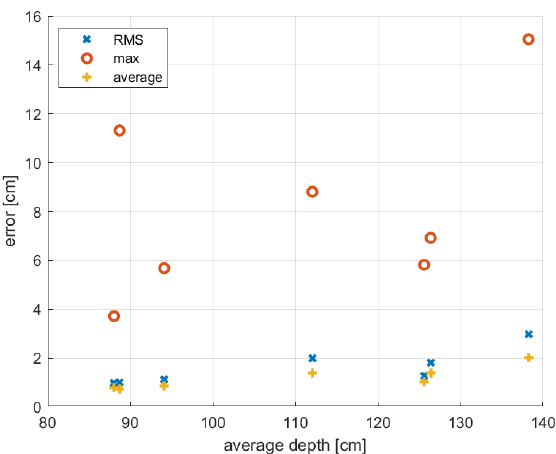
Figure 6. Depth error on a planar surface varying the average depth from the cameras.